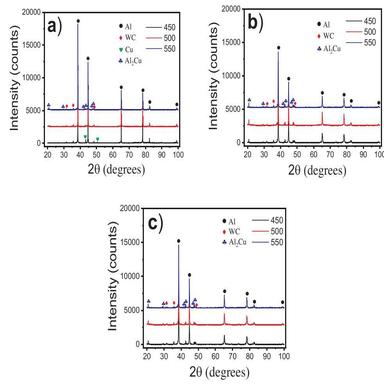
X-ray diffraction patterns of Al-Cu-Mg/WC composites prepared with different sintering temperatures and milling times: a) 0 h, b) 3 h, and c) 5 h.